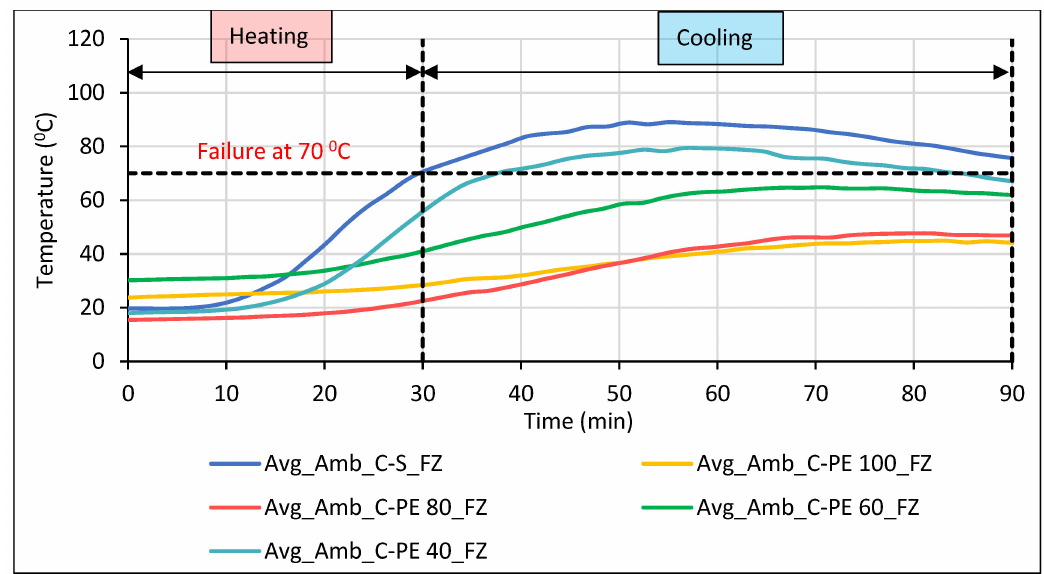
Figure 37. Comparison of the ambient side block surface temperatures from the bushfire